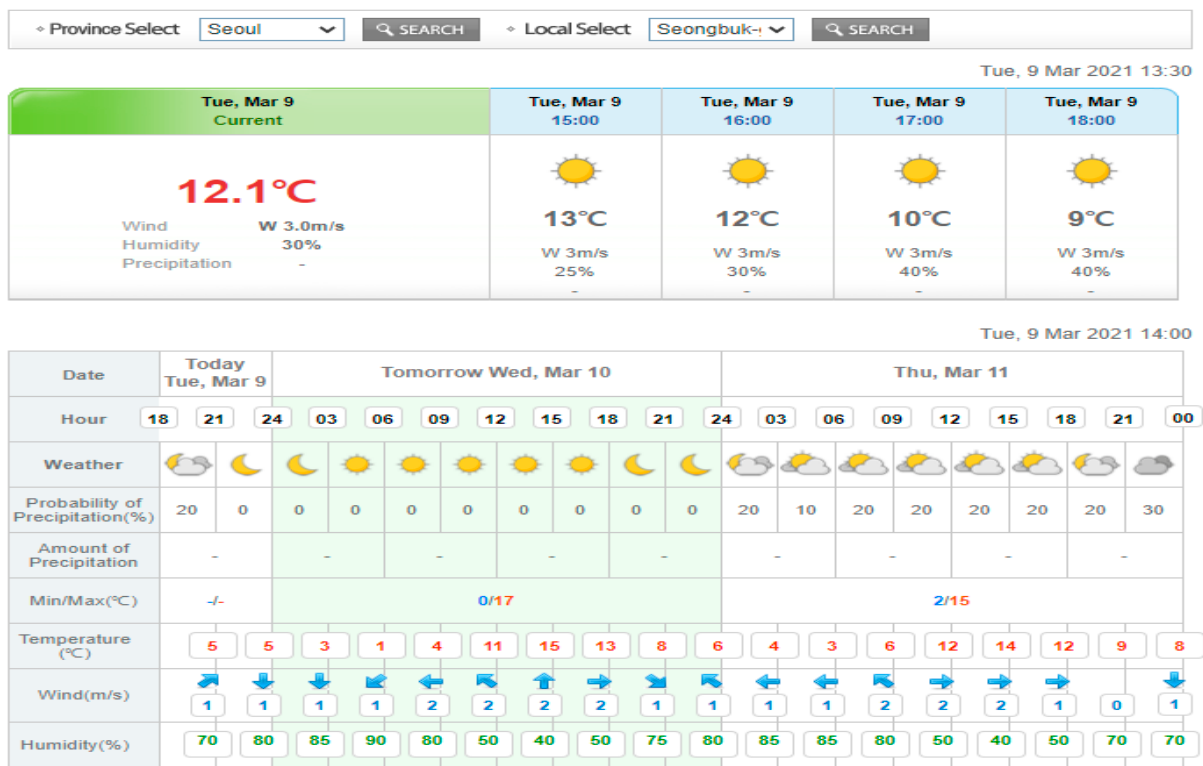
Figure 1. Example of Dong-Nae forecast by the Korea Meteorological Administration.